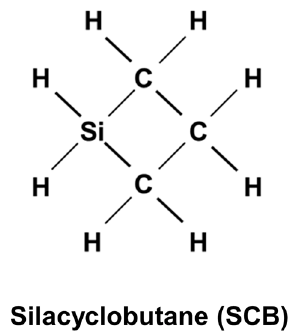
Figure 1. Chemical vapor deposition (CVD) source for SiC membranes.